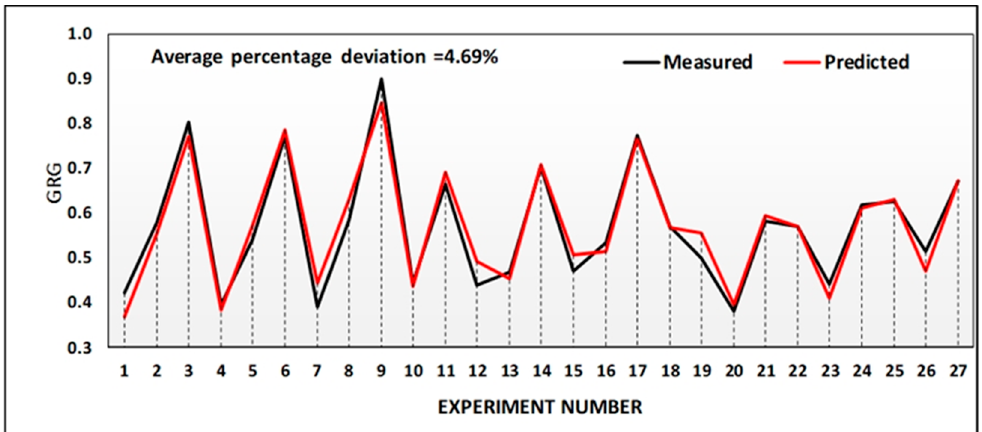
Figure 6. Comparison of measured GRG and predicted GRG values.